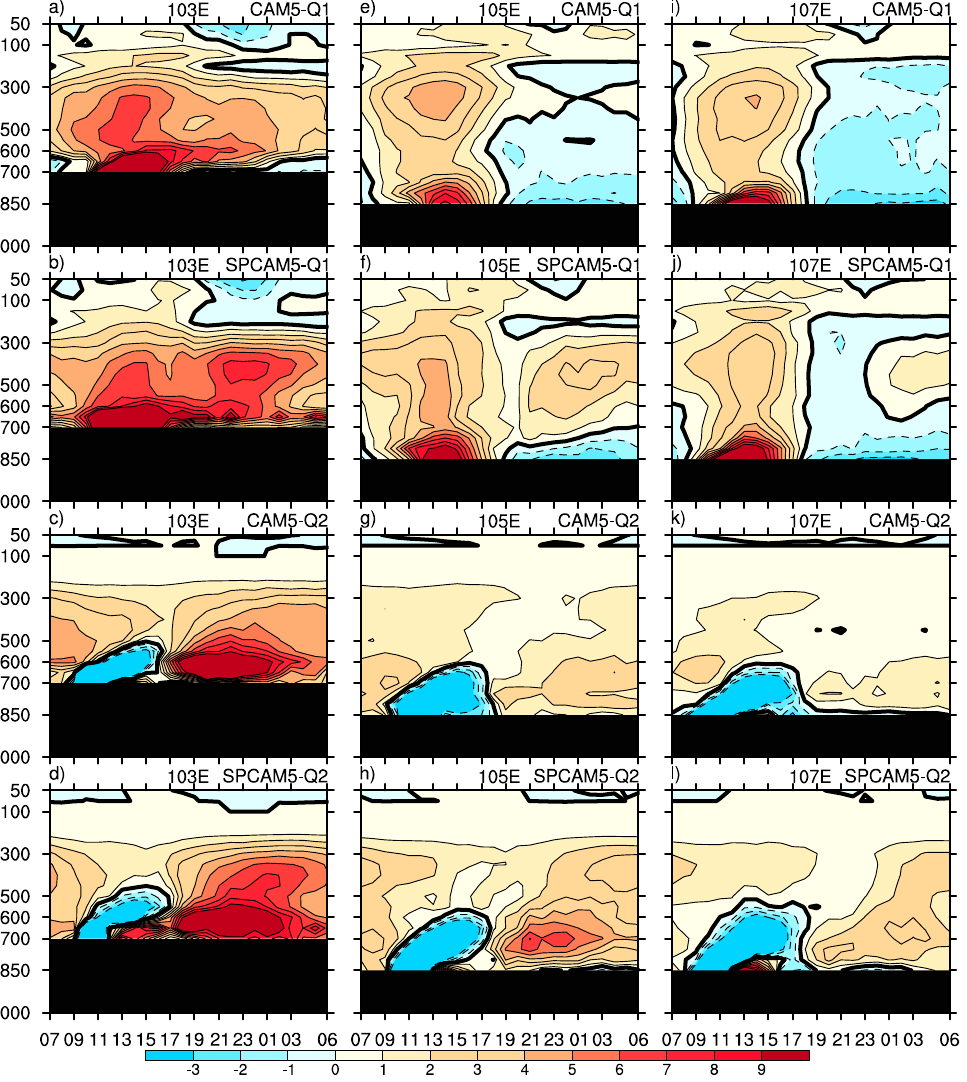
Figure 4. The hour–pressure transects of apparent heat source ( Q 1 ) and apparent moisture sink ( Q 2 ) averaged within 27–30 ◦ N at 103 ◦ E for ( a ) Q 1 in CAM5, ( b ) Q 1 in SPCAM5, ( c ) Q 2 in CAM5, ( d ) Q 2 in SPCAM5, ( e – h ) same as ( a – d ), but at 105 ◦ E; ( i – l ) same as ( a – d ), but at 107 ◦ E, unit: K · day − 1